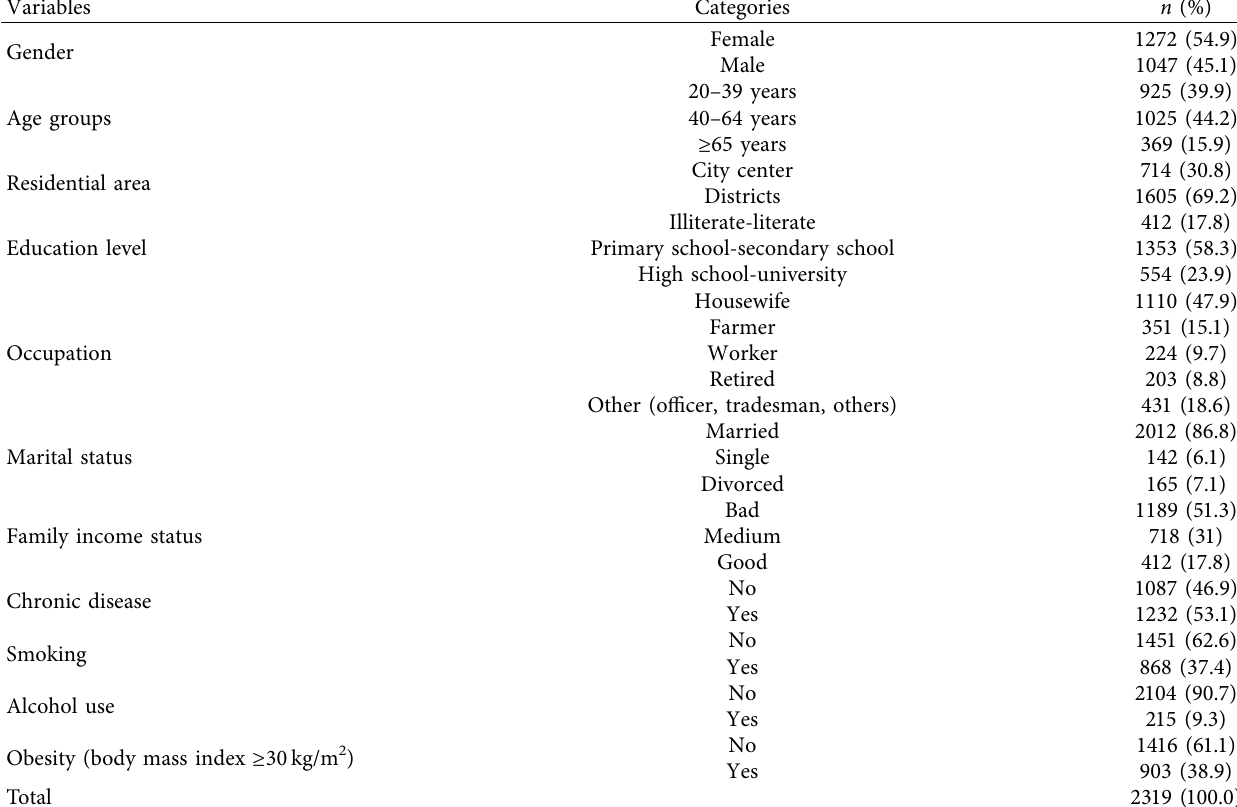
Table 1: Distribution of the participants according to some descriptive characteristics.